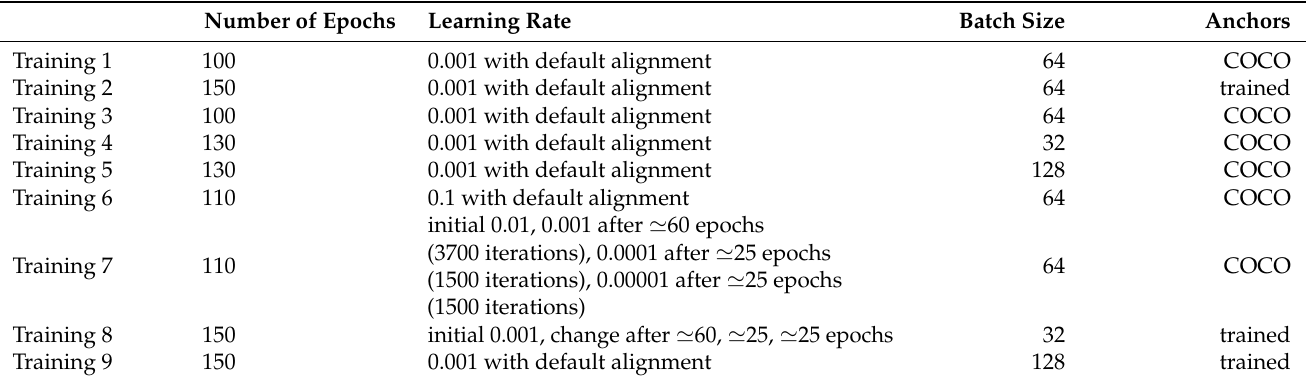
Table 2. Training